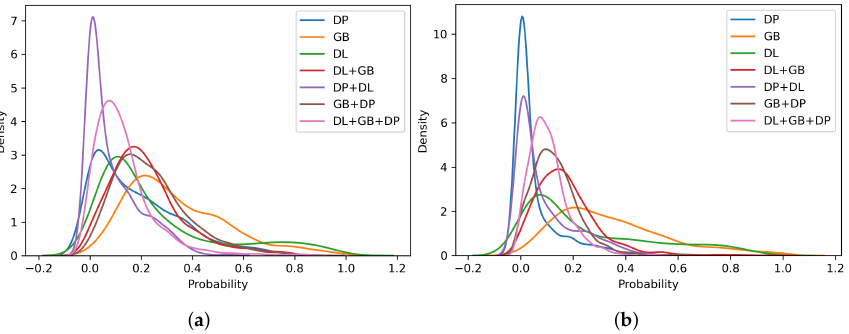
Figure 15. Probability distributions of ( a ) real and ( b ) fake fingerprint scores of the Orchantus 2019 dataset obtained by the PAD